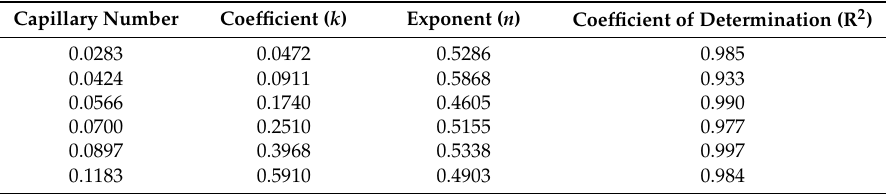
Table 4. Power law fitting